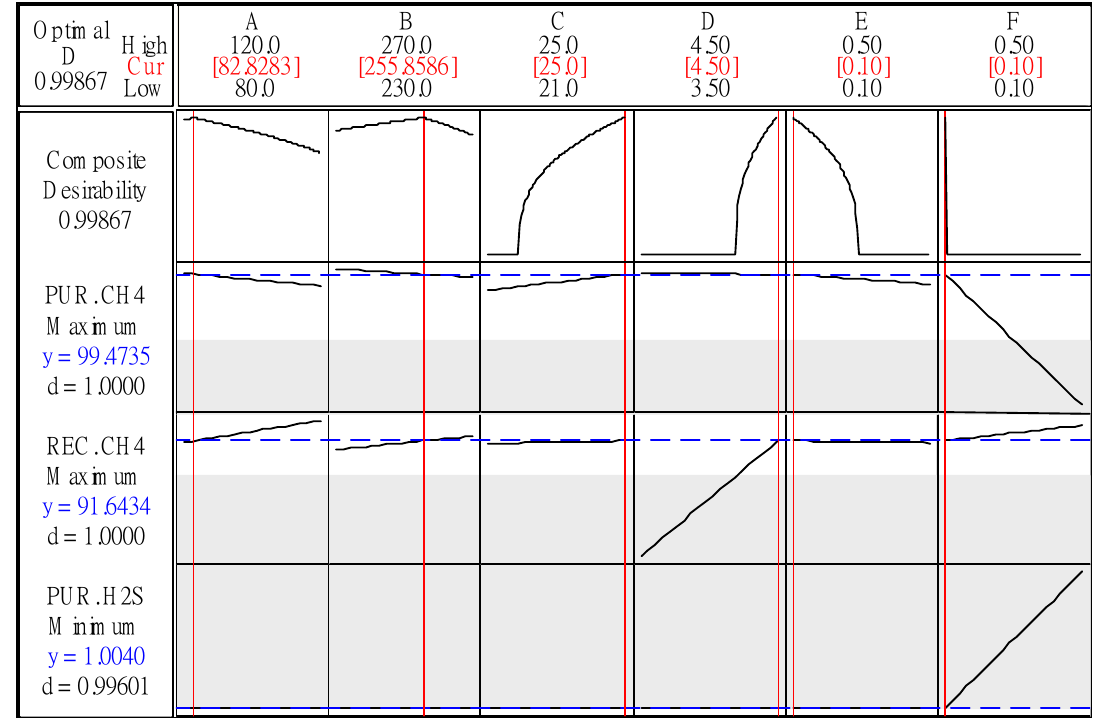
Figure 11. The optimal response of regression from top product CH 4 purity (PUR. CH 4 ), top product CH 4 recovery (REC. CH 4 ), and top product H 2 S purity (PUR. H 2 S). A, adsorption step time; B, purge step time; C, bed length; D, feed pressure; E, vacuum pressure; F, purge pressure. Table 16. The optimal results for each factor after analyzing from Minitab.